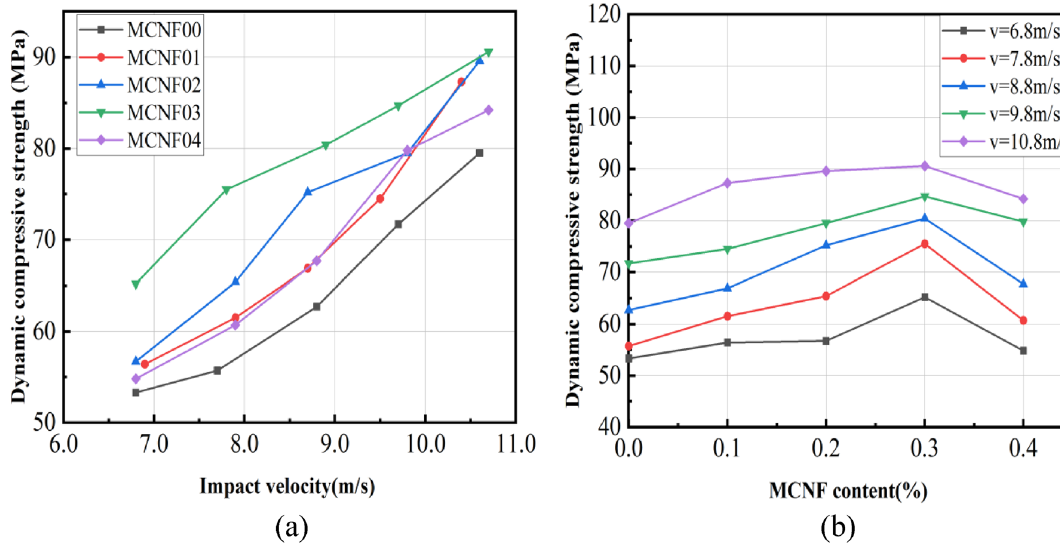
Figure 7. Relationship between impact velocity, MCNF content and dynamic compressive strength.